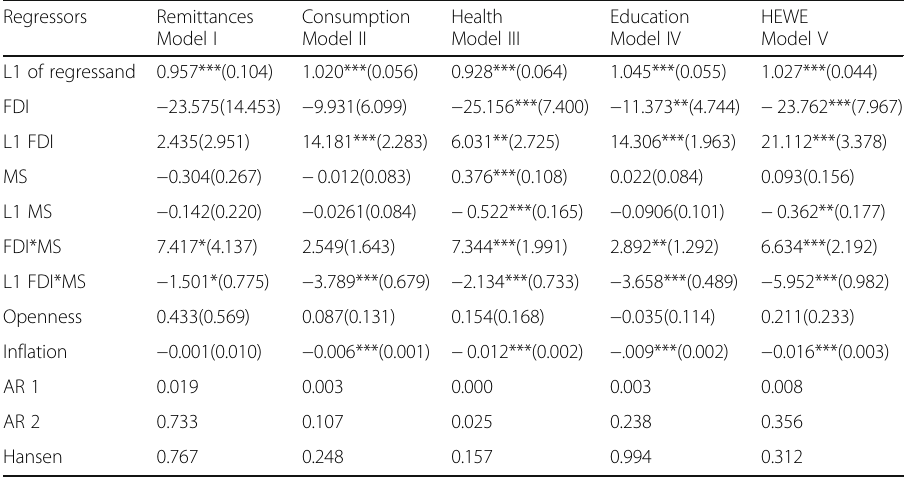
Table 10 FDI and money supply as proxies for foreign capital inflows and financial development respectively